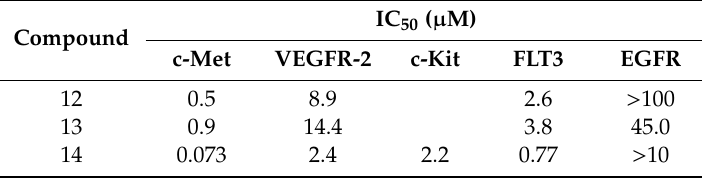
Table 5. Inhibition of kinases by compounds 12 , 13 and 14